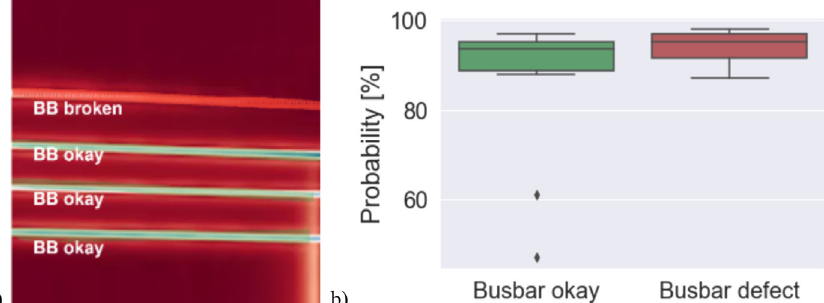
Fig. 8. Example result with both intact and broken busbars labeled by the neural network (a) and detection probabilities for intact and broken busbars